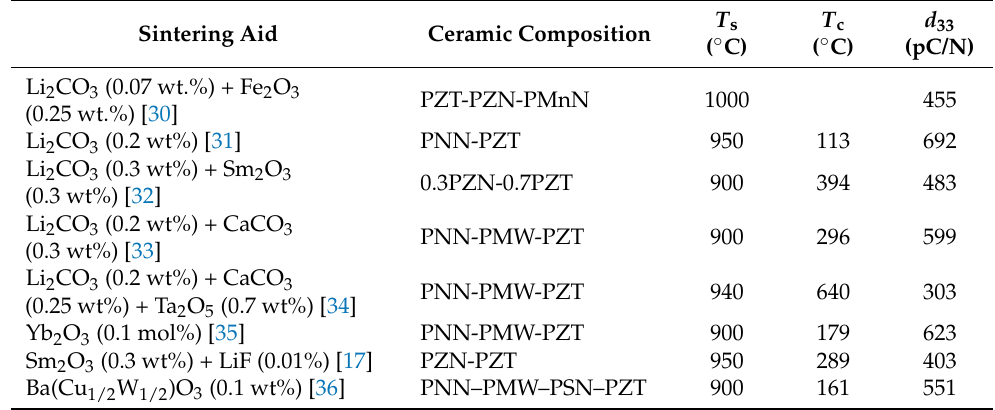
Table 1. Comparison of piezoelectric properties of PZT-based ceramics with sintering aids ( T s : sintering temperature; T c : Curie